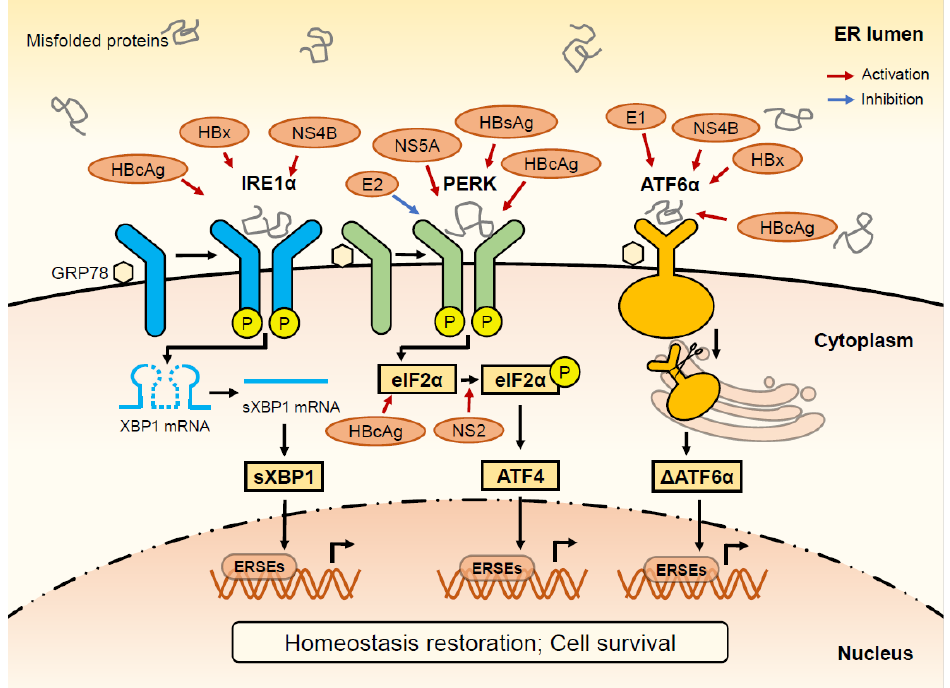
Figure 1. Mainstay of the three signal transduction pathways of the unfolded protein reaction (UPR). IRE1α, PERK and ATF6 are transmembrane proteins localized on the endoplasmic reticulum (ER) membrane and can be activated by the misfolded proteins in the ER lumen. In the cytoplasm, a 26-nt intron in X-box-binding protein 1 (XBP1) mRNA can be excised by the IRE1α, and then converted to its mature form encoding spliced XBP1 (sXBP1). PERK could phosphorylate eIF2α, and therefore promote the ATF4 expression. ATF6α translocates to the Golgi apparatus where it is cleaved to form cleaved ATF6α (ΔATF6α). sXBP1, ATF4, and ΔATF6α translocate to the nucleus where they are able to regulate the transcription of ER stress-responsive genes. ΔATF6α, sXBP1, and ATF4 also interact with several ER stress-response elements (ERSEs), resulting in the transactivation of unfolded protein response target genes, and finally function to restore homeostasis and avoid cell death.